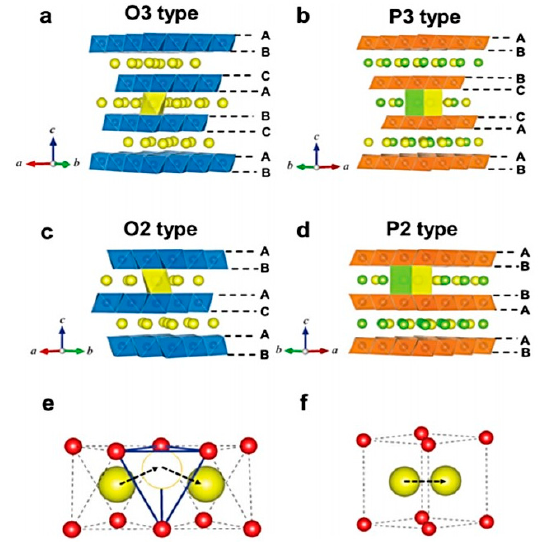
Figure 1. Schematic illustrations of definitions of layered NaTMO 2 phases of ( a ) O3 type, ( b ) P3 type, ( c ) O2 type, and ( d ) P2 type. Illustrations of Na + ion diffusion pathways through ( e ) indirect tetrahedral sites in the O-type stacking sequence and ( f ) direct prismatic sites in the P-type stacking sequence. Reproduced with permission from [41] Copyright 2016 Royal Society of Chemistry.